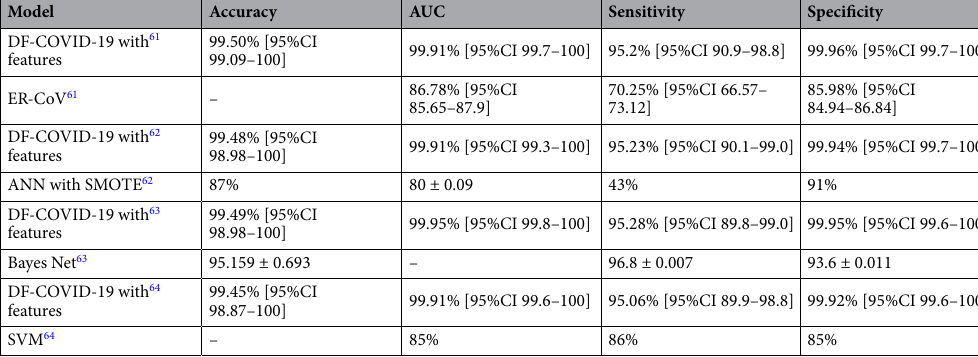
Table 5. The comparison results between DF-COVID-19 and other